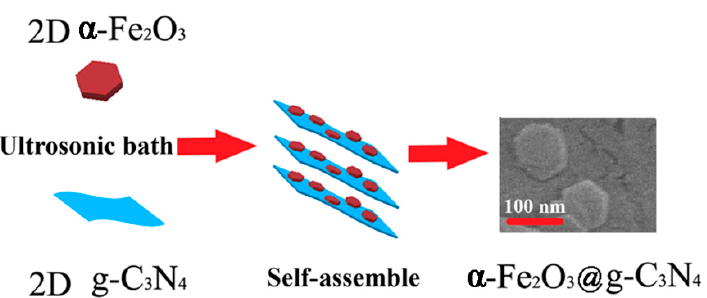
Figure 7. Schematic illustration for the 2D α -Fe 2 O 3 @g-C 3 N 4 photocatalyst synthesis.